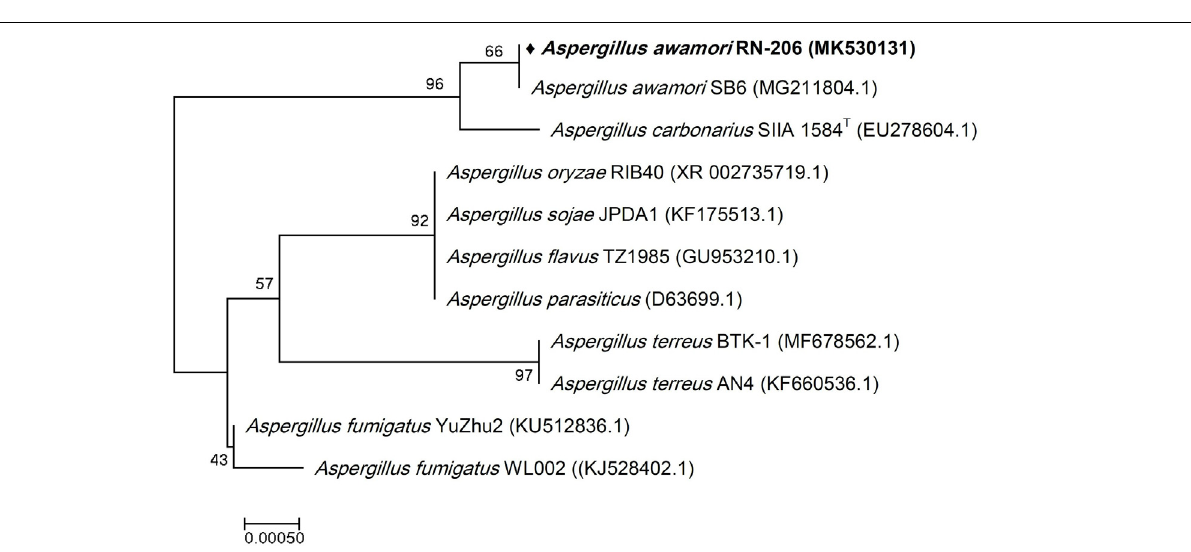
FIGURE 3 | Phylogenetic tree of the River Nile derived Aspergillus awamori RN-206 based on partial 18S rRNA gene sequences. The phylogenetic tree was inferred using the Neighbor-Joining method (Saitou and Nei, 1987). The distances were computed using the Kimura 2-parameter method (Kimura, 1980) and are in the units of the number of base substitutions per site. Numbers at nodes indicate percentages of 1000 bootstrap re-samplings. All positions containing gaps and missing data were eliminated. Evolutionary analyses were conducted in MEGA7 (Kumar et al., 2016).